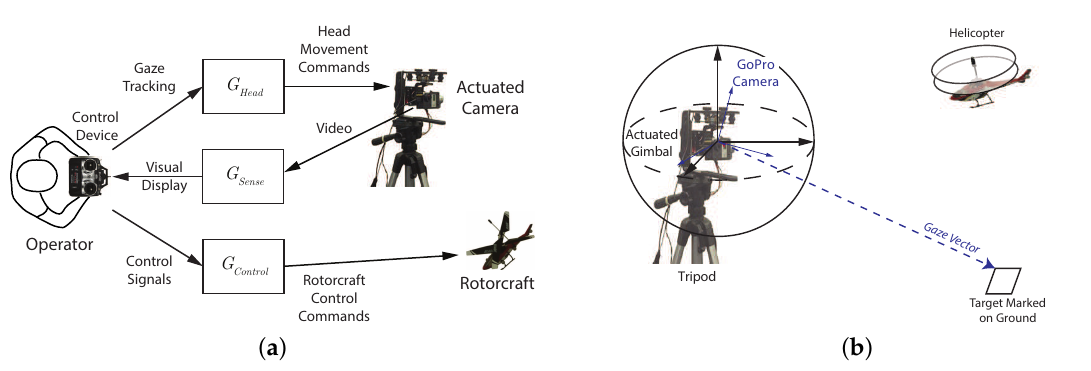
Figure 3. Teleoperation block diagram and physical representation. ( a ) The teleoperation configuration showing the information filters on the sensing and control capabilities of the operator. ( b ) Teleoperation camera, gimbal, vehicle, and task